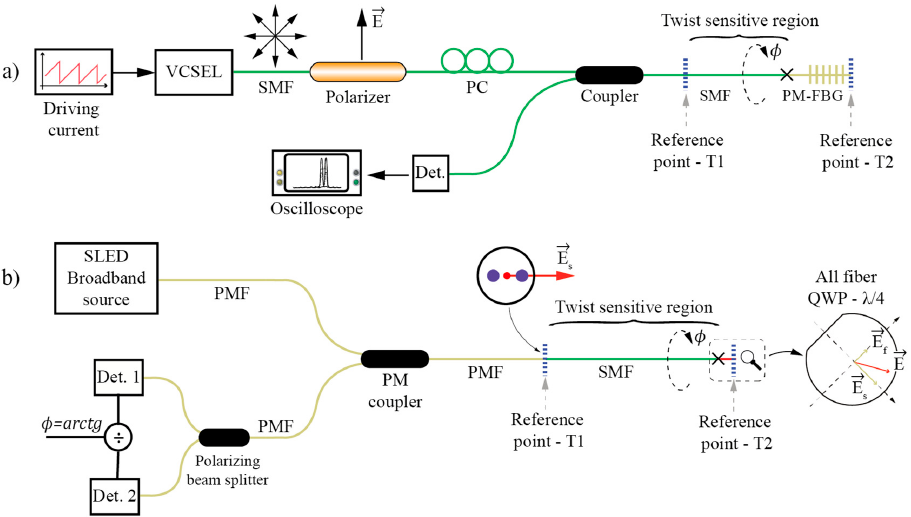
Figure 17. E-field vector displacement rotation sensors using single lead fiber solutions with E-field rotation encoding employing ( a ) An FBG inscribed in the Hi-Bi fiber; and ( b ) An all-fiber wave-plate.